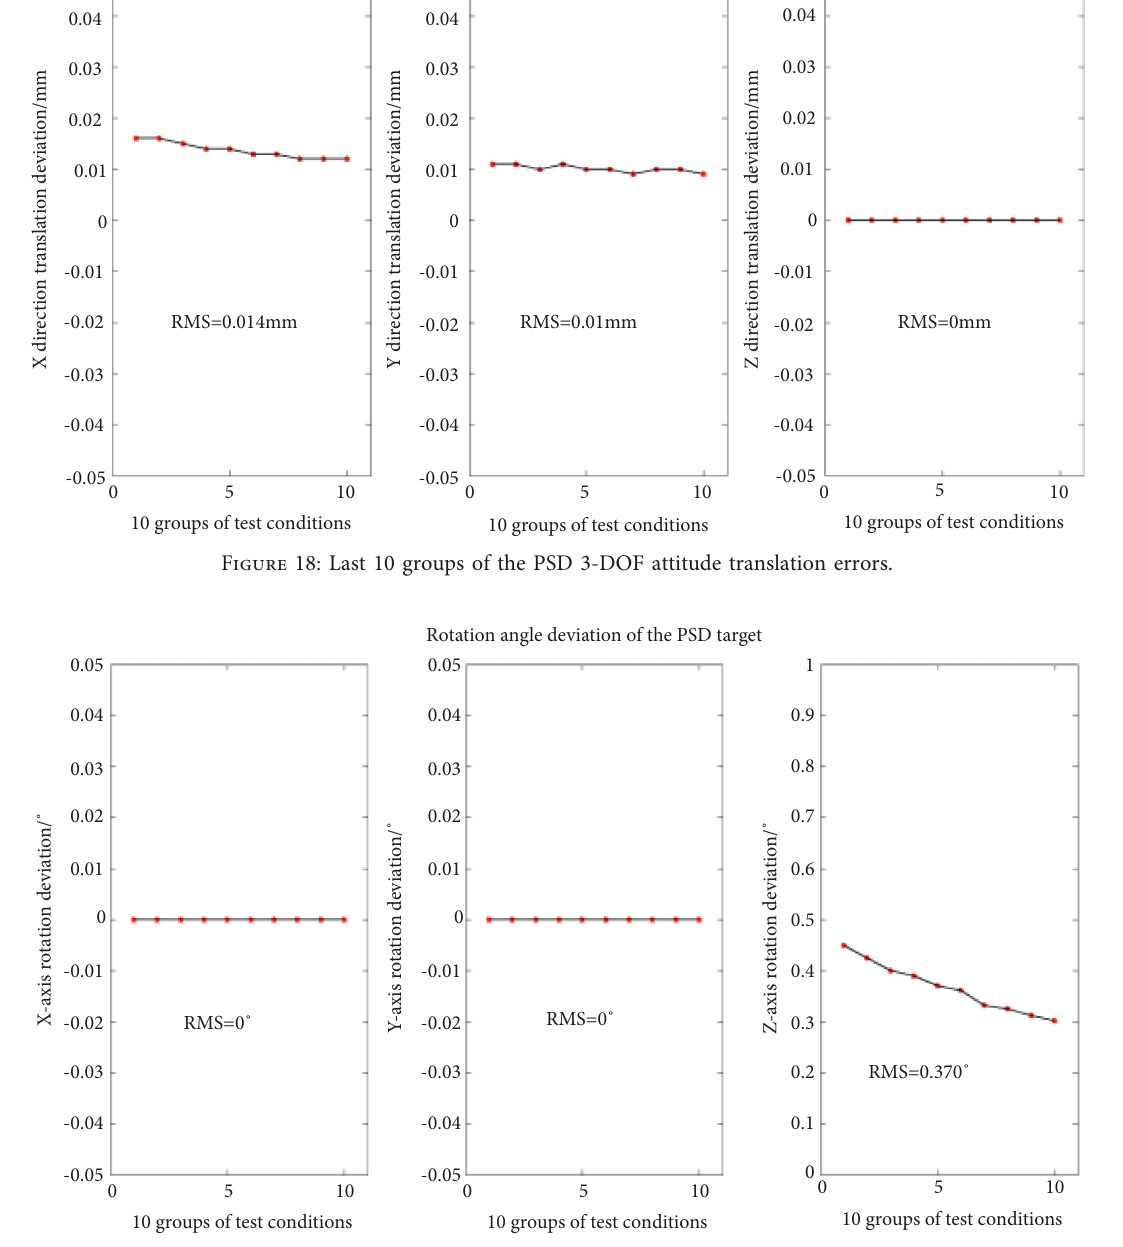
Figure 19: Last 10 groups of PSD 3-DOF attitude rotation